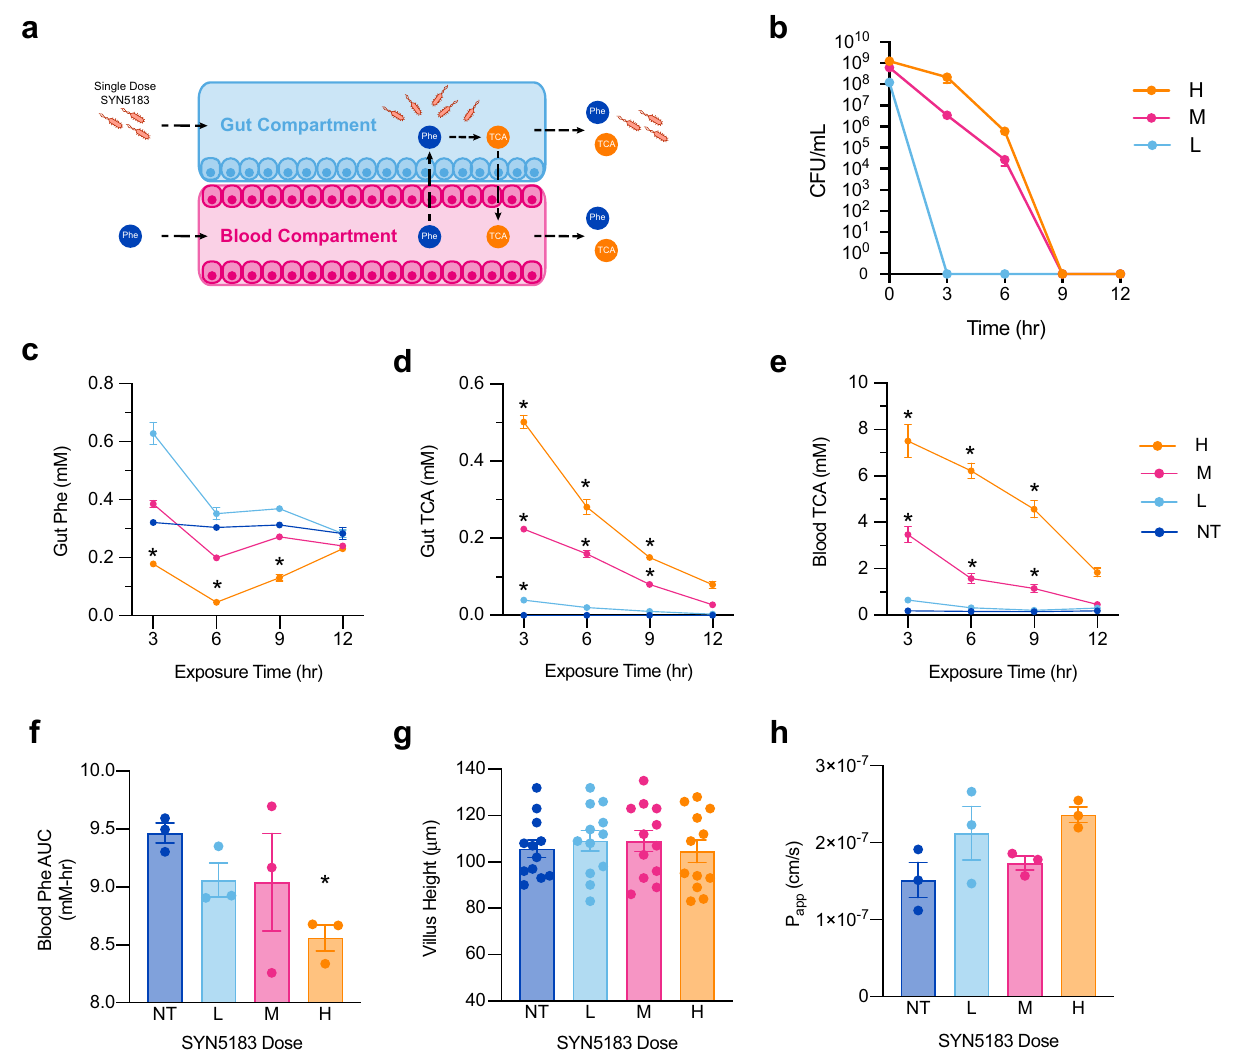
Fig. 4 Blood Phe lowering a human gut-chip model with administration of SYN5183. a Schematic of study design. A single dose of SYN5183 was administered in the gut compartment, while 1.0 mM Phe was administered continuously to the blood compartment. SYN5183 CFU was enumerated from gut compartment ef fl uents, and Phe and TCA were quanti fi ed using ef fl uents collected from the gut and blood compartments. ( b – d , n = 3 gut chips) Concentrations of SYN5183 ( b ; CFU/mL), Phe ( c ; mM), and TCA ( d ; mM) recovered from gut compartment ef fl uents over time. ( e , n = 3 gut chips) Concentrations of Phe (mM) recovered from blood compartment ef fl uents over time. f Area under the curve (AUC; mM-hr) of Phe recovered from blood compartment ef fl uents over 12 h. ( g , h , n = 3 gut chips, villus height measurements were acquired from 4 ROIs per image) Villus height ( μ m) and apparent permeability ( P app ; cm/s) across the gut barrier 12 h post-dose. For ( b – h ), H, M, and L correspond to SYN5183 doses of 1.25 × 10 9 CFU/mL, 6.25 × 10 8 CFU/mL, and 1.25 × 10 8 CFU/mL, respectively. NT corresponds to non-treated chips. * p < 0.05; 2-way ANOVA, with a post-hoc Tukey analysis using a 95% con fi dence interval compared to the NT group, error bars represent SEM with the middle point representing the mean value. Source data are provided as a Source Data fi